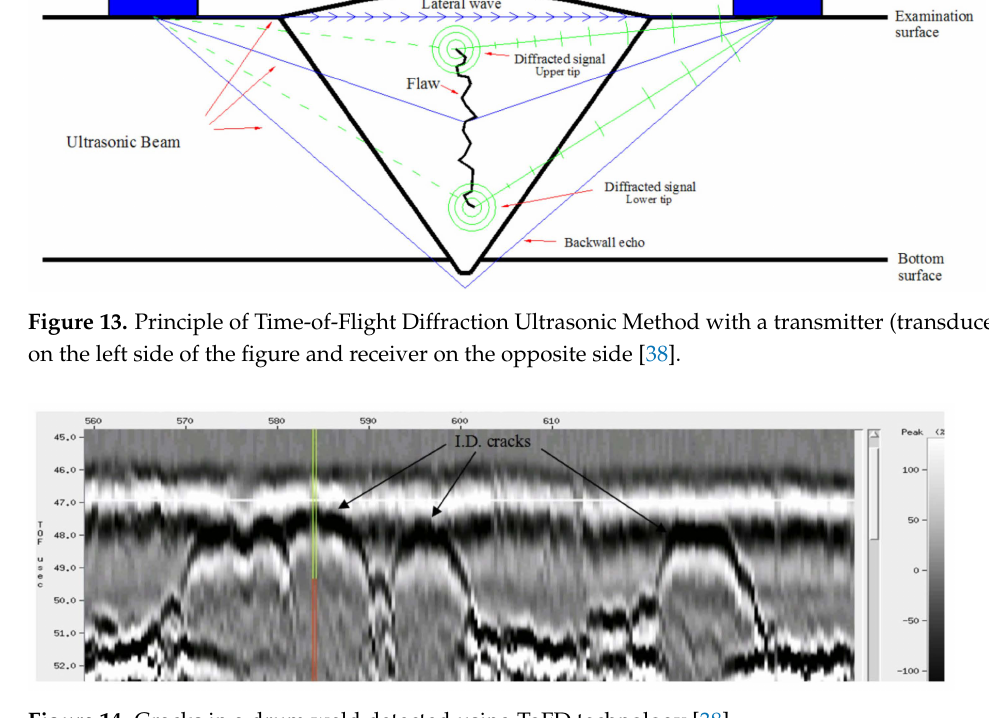
Figure 14. Cracks in a drum weld detected using ToFD technology [38].